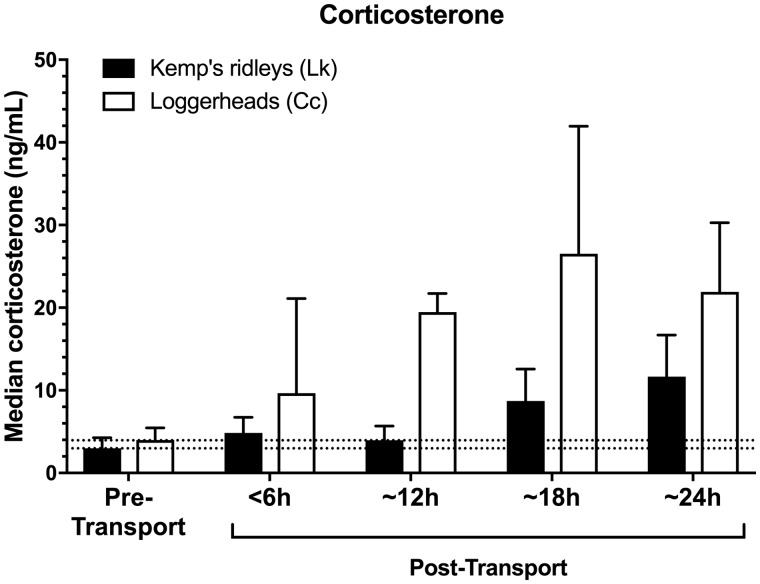
Post-transport corticosterone in Kemp’s ridley and loggerhead turtles when compared with pre-transport baselines. Dashed lines indicate pre-transport medians (i.e., bars on left), for visual comparison to post-transport concentrations in both species. Corticosterone was not normally distributed; bars indicate median±quartiles.